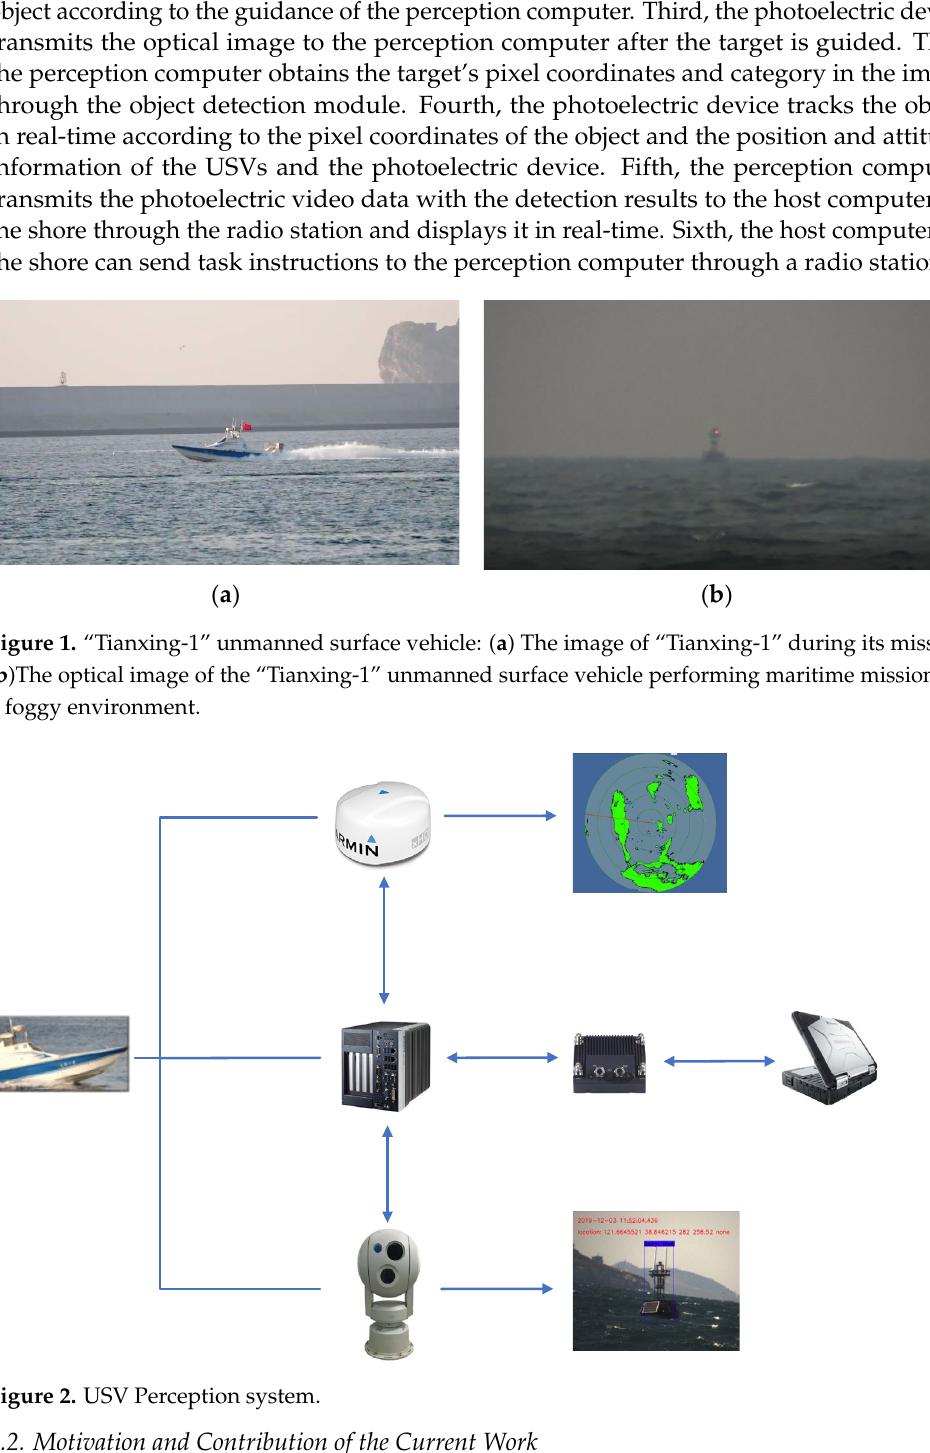
Figure 1. “Tianxing-1” unmanned surface vehicle: ( a ) The image of “Tianxing-1” during its mission; ( b )The optical image of the “Tianxing-1” unmanned surface vehicle performing maritime missions in a foggy environment.